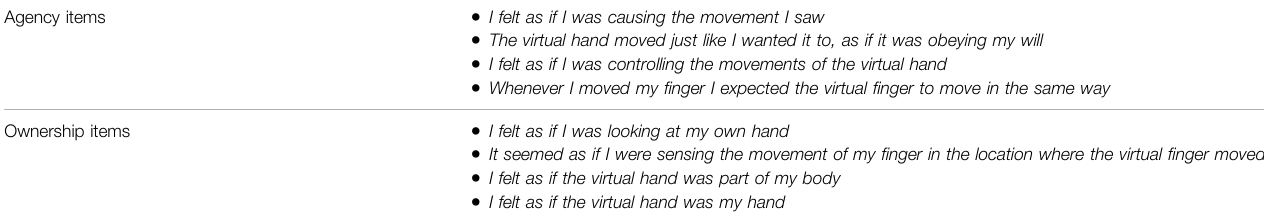
TABLE 2 | Agency and ownership questionnaire. Agency